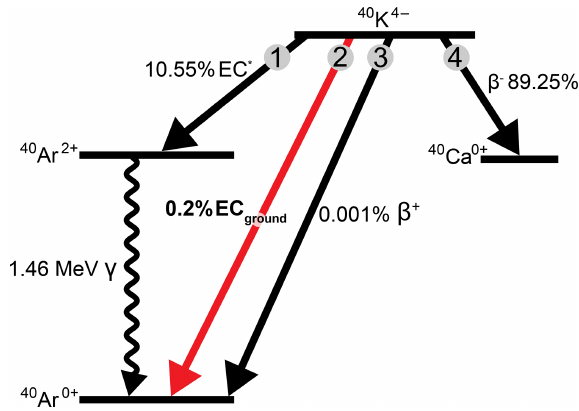
Figure 1. Decay scheme of 40 K following McDougall and Harri- son (1999) and Leutz et al. (1965), where 1 is the electron capture branch to the excited state of 40 Ar with y-ray emission (EC*), 2 is the electron capture direct to the ground state of 40 Ar (EC ground ), 3 is the positron decay to ground state of 40 Ar, and 4 is the β decay to the ground state of 40 Ca. The disputed decay mode, EC ground , is highlighted in